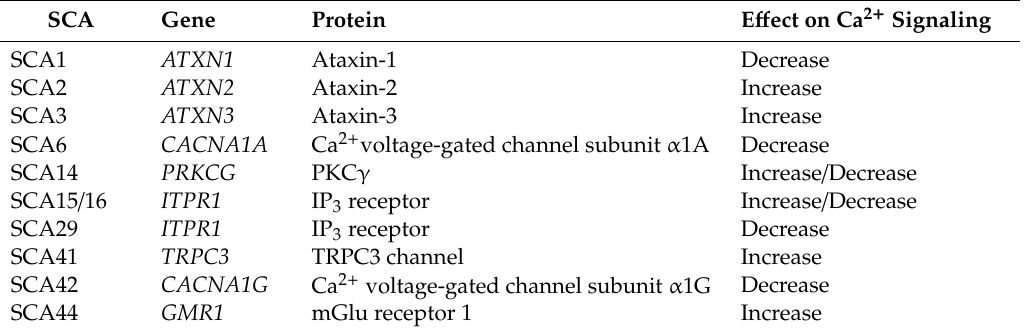
Table 2. Features of SCAs linked with abnormal Ca 2 +